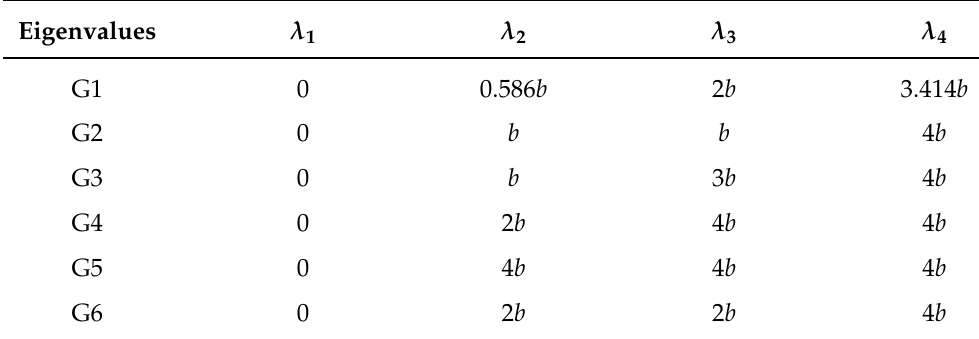
Table 1. Eigenvalues of the six different